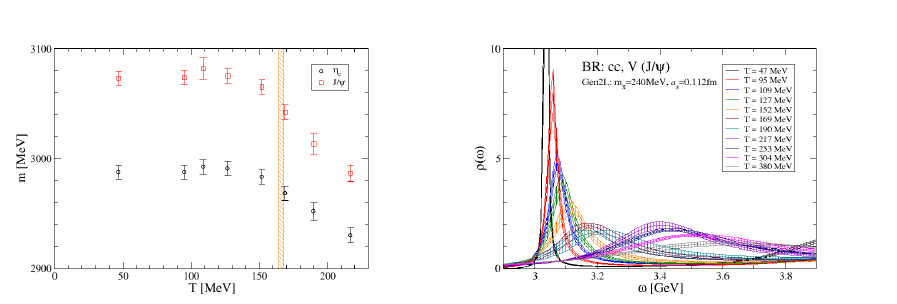
Figure 3. Left: J /ψ and η c masses from analysis of smeared correlators. The vertical band indicates the chiral crossover. As the analysis assumes narrow bound states, the results for T > T c cannot be taken as evidence that these states survive in the quark–gluon plasma. Right: J /ψ spectral functions from the BR method.